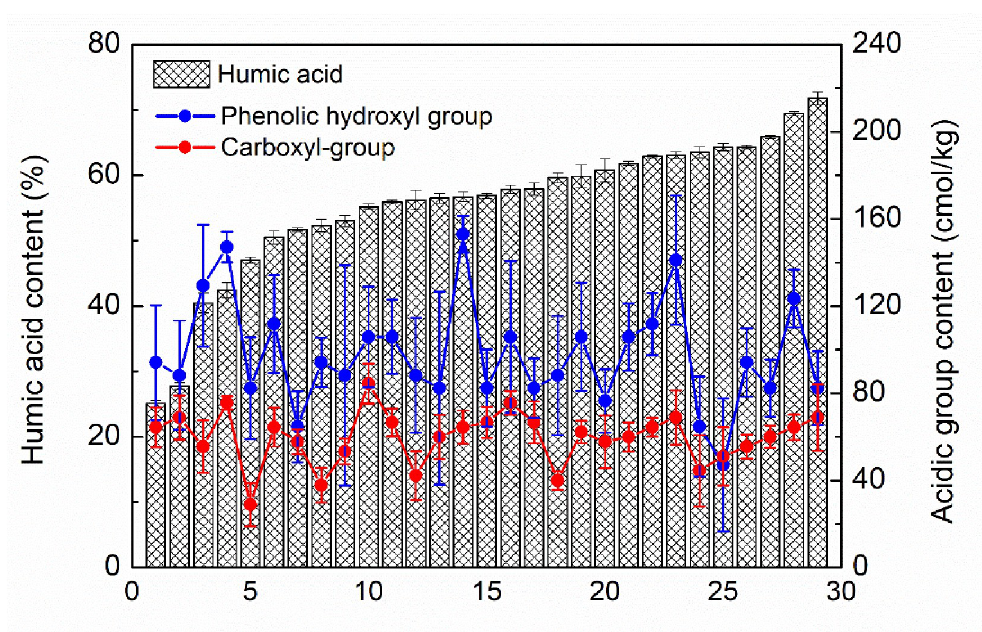
Fig 11. Phenolic-hydroxyl and carboxyl-groups contents in humic acid